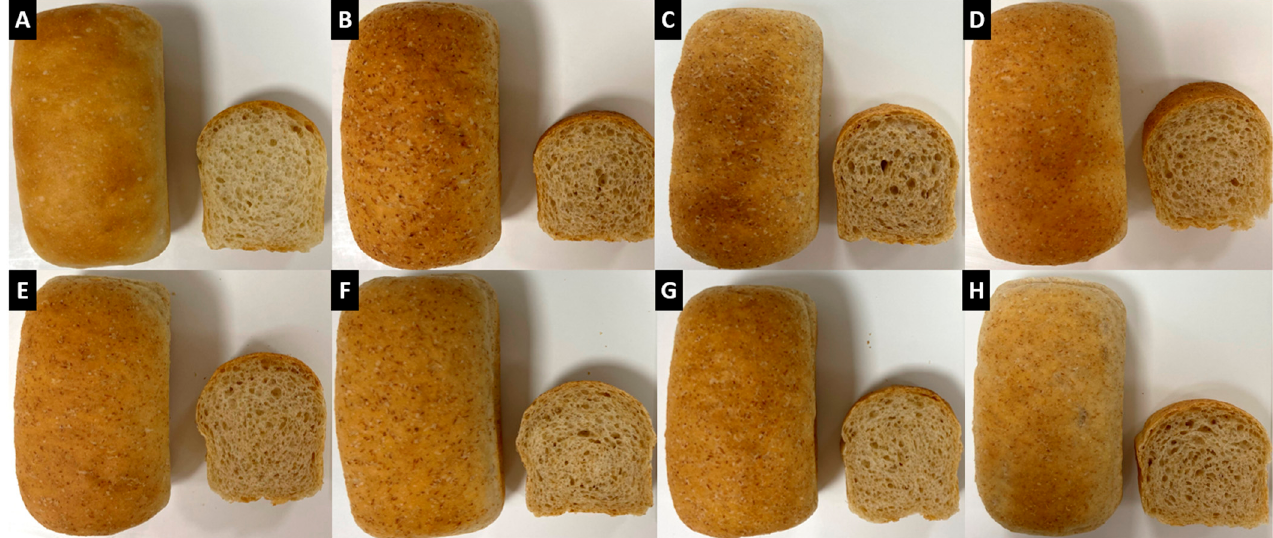
Figure 2. Images of rootlet breads produced during baking trials. Images ( A – C ) represent control recipe breads made with bakers’ flour, unfermented barley rootlets, and sterilised barley rootlets, respectively. Images ( D – H ) illustrate breads made with fermented barley rootlets with the strains Leuconostoc citreum TR116, Weissella cibaria MG1, Lactobacillus amylovorus FST2.11, Limosilactobacillus reuteri R29, and Lactiplantibacillus plantarum FST1.7, respectively.